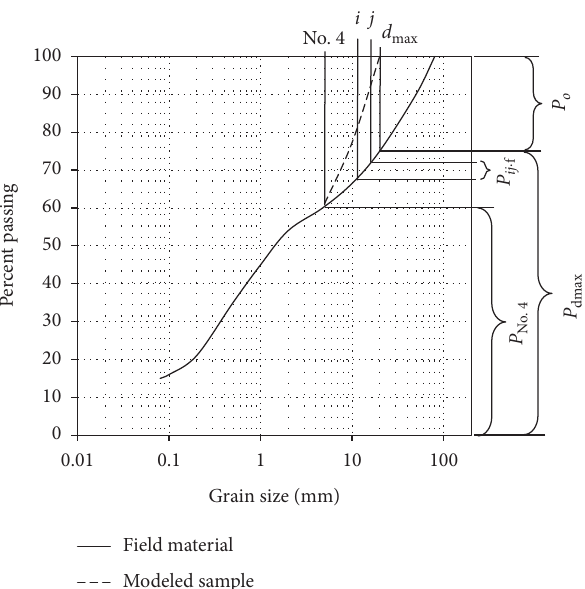
Figure 8: Grain size distribution curves of field material and a modeled sample (data taken from